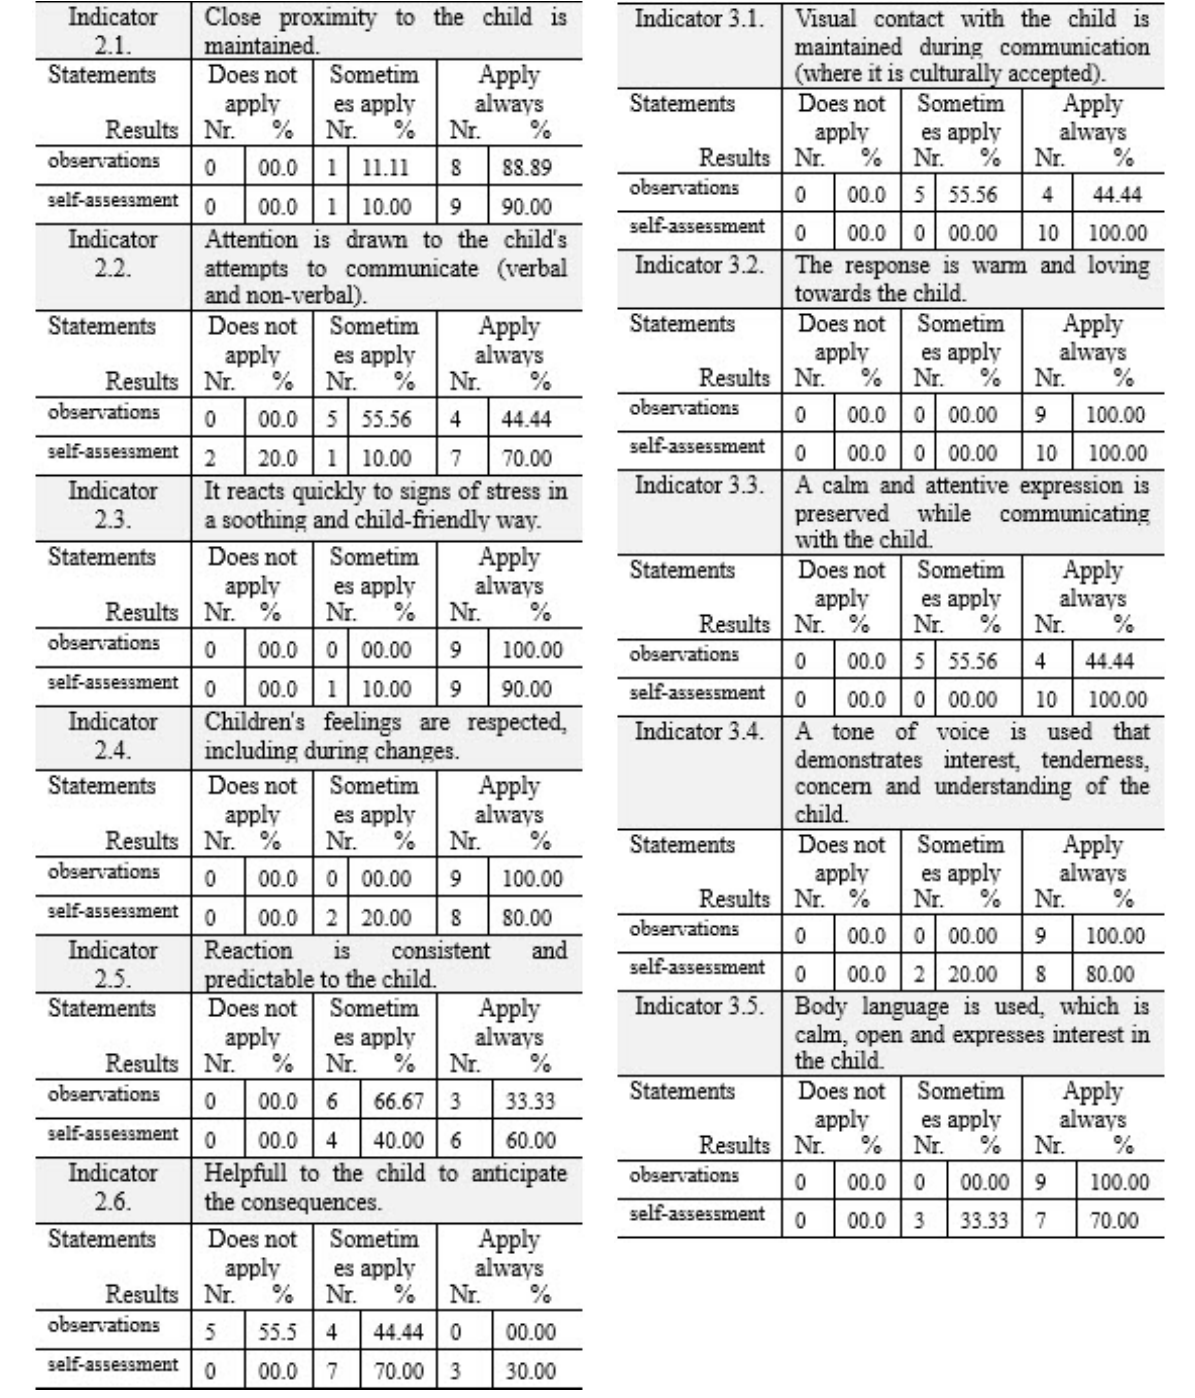
Table 2. Principle 2: Relationships are deepened by interactions that create a strong attachment.